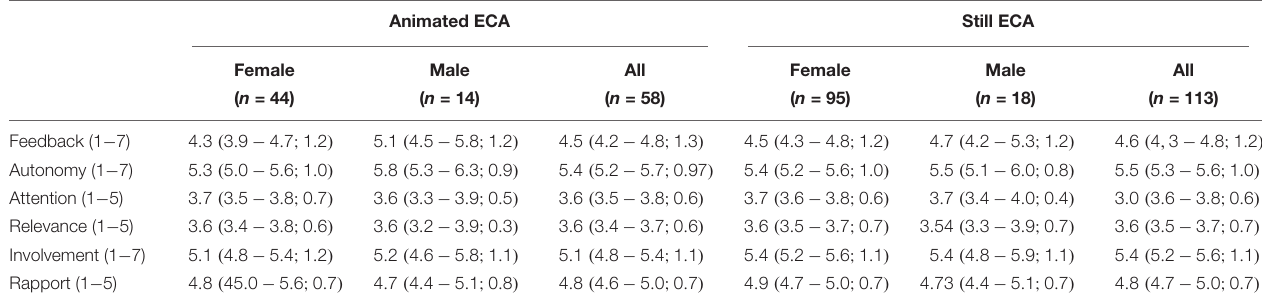
TABLE 3 | Mean scores, CI and standard deviation on the animated-still